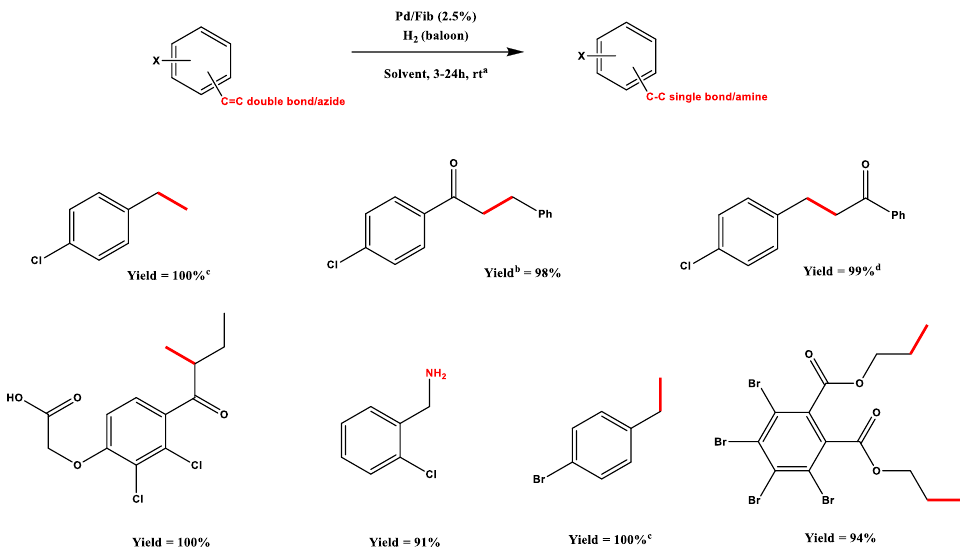
Table 3. Major fruit peel waste-producing countries. Adapted from Reference [71]. Copyright 2015, Walter de Gruyter